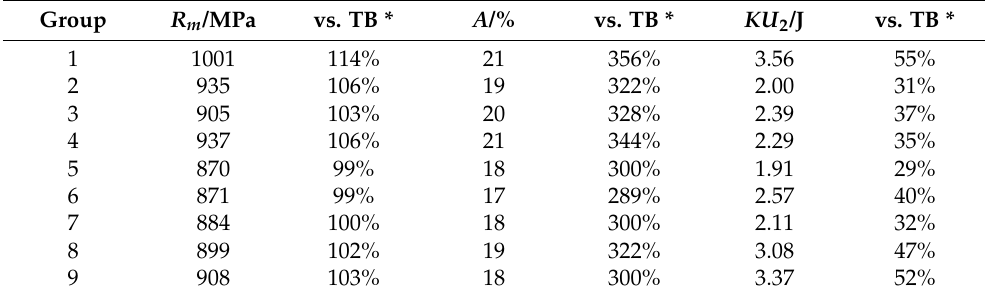
Table 3. The tensile properties ( R m and A ) and impact toughness ( KU 2 ) of each welded specimen. Group R m /MPa vs. TB * A /% vs. TB * KU 2 /J vs. TB